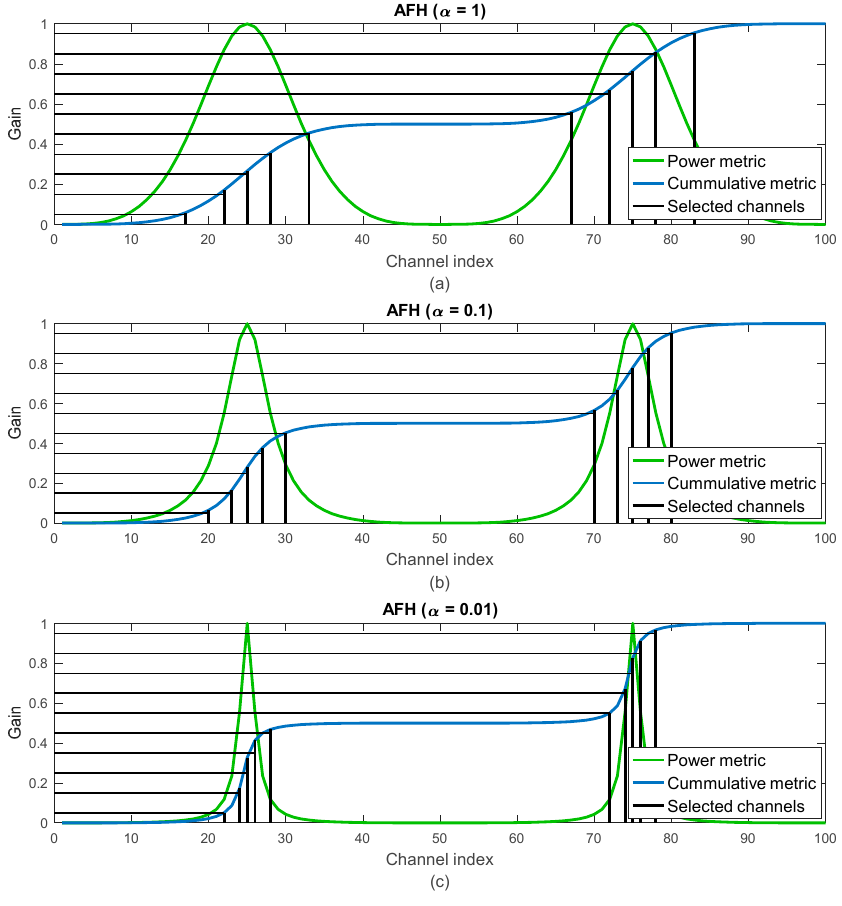
Figure 10. Channel selection evolution in the Advanced Frequency Hopping (AFH) technique when varying the α parameter: ( a ) α = 1; ( b ) α = 0.1; ( c ) α =